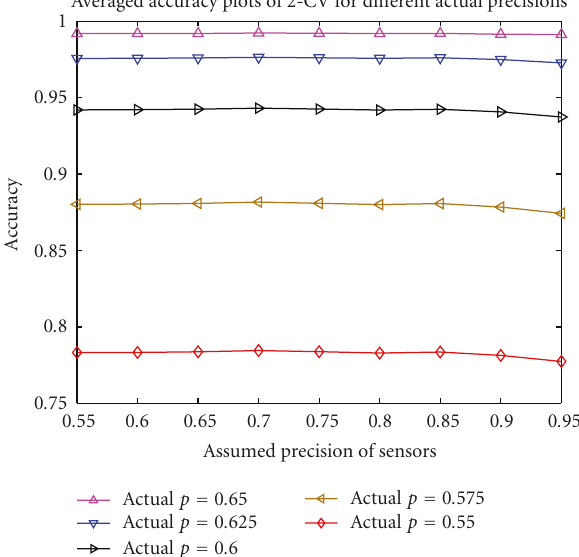
Figure 11: Perturbation analysis: numerically computed accuracy plot with respect to assumed precision of sensors. Di ff erent plots are for di ff erent values of actual precision p